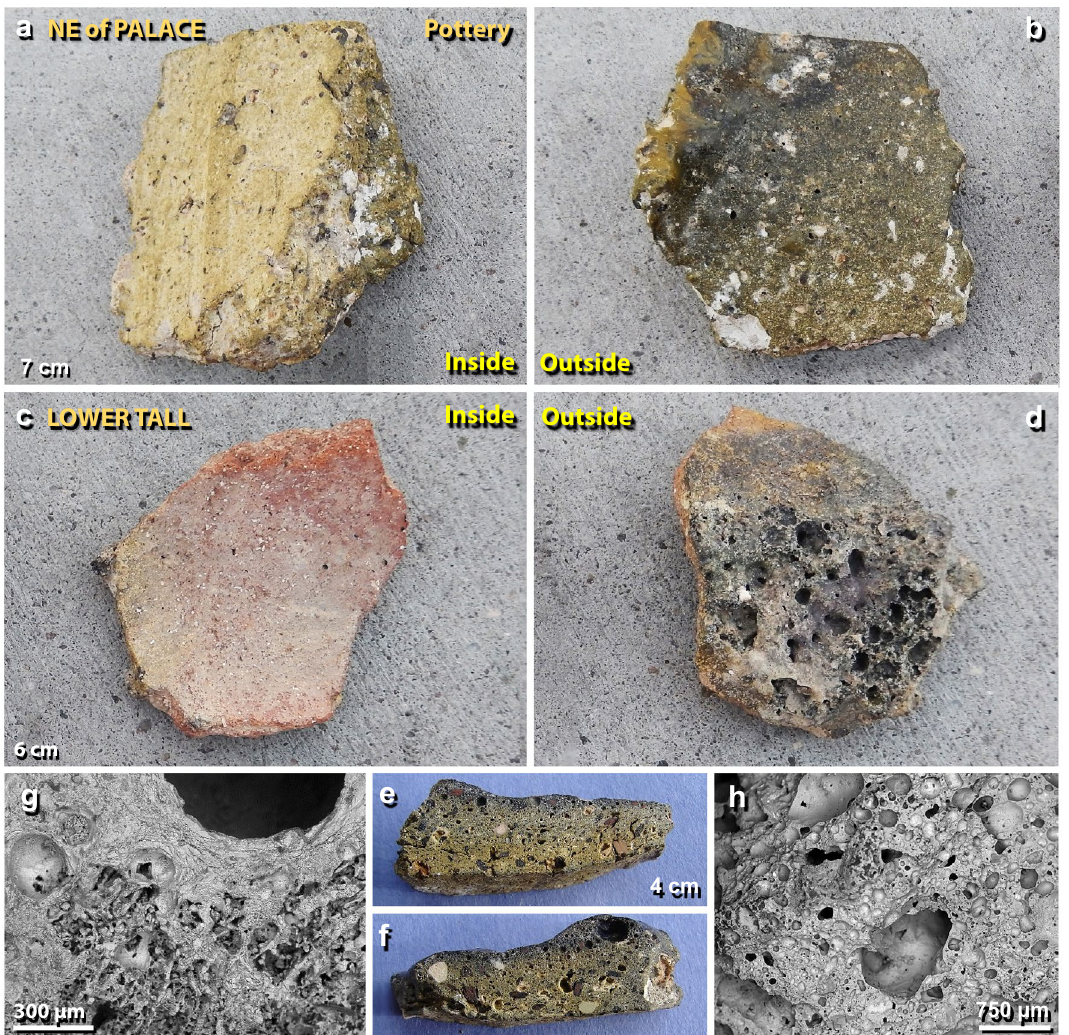
Figure 10. Melted pottery. ( a ) Photos of a 7-cm-wide potsherd from a broken storage jar from NE of the palace, showing unmelted inner surface and ( b ) the darker melted outer surface of the potsherd. The upper-left edge in panel ‘ b ’ is the outward-curved lip of a storage jar. ( c ) Potsherd of a 6-cm-wide storage jar from the lower tall, displaying an unaltered inner surface, and ( d ) the highly vesicular outer surface. ( e )–( f ) Photos of both edges of the sliced section of sherd in panels ‘ a ’ and ‘ b ’ above. ( g )–( h ) SEM images of the highly vesicular sliced surface of sherd in panels ‘ a ’ and ‘ b